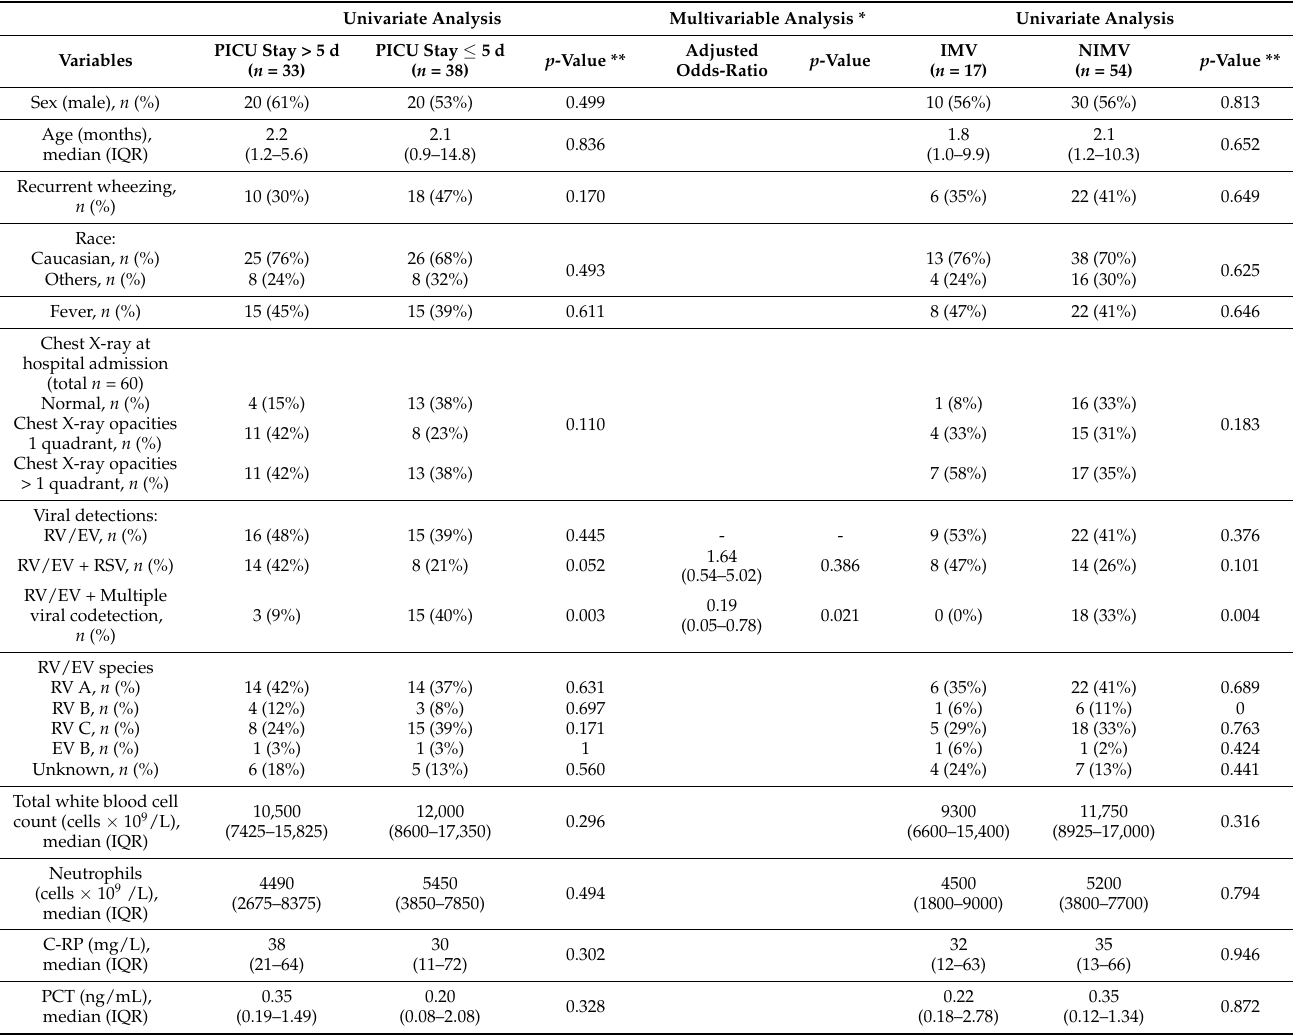
Table 3. Outcome variables: PICU length of stay and need for invasive mechanical ventilation. Univariate Analysis Multivariable Analysis